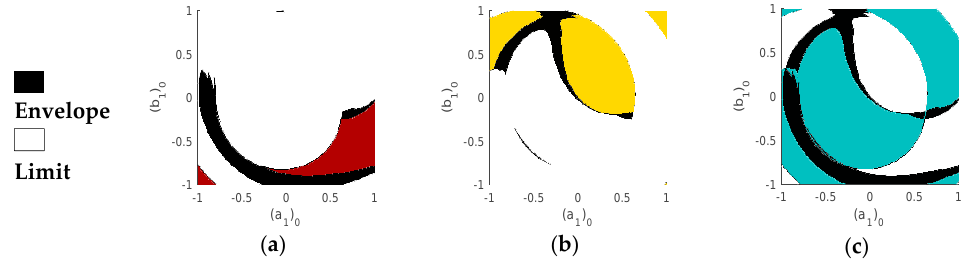
) for σ = − 1 and , ( b 1 ) 0 0 = 2%. l